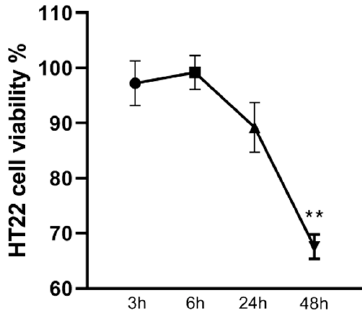
Figure 2. The effects of conditioned medium obtained from BV2 inflamed microglia on HT22 cell viability. Cell viability is expressed as the percentage of untreated cells (vehicle alone = 100% cell viability). Graph shows the mean + SEM of three independent experiments performed in triplicate. The statistically significant differences between experimental conditions and untreated control cells are shown by asterisks (** p < 0.01).